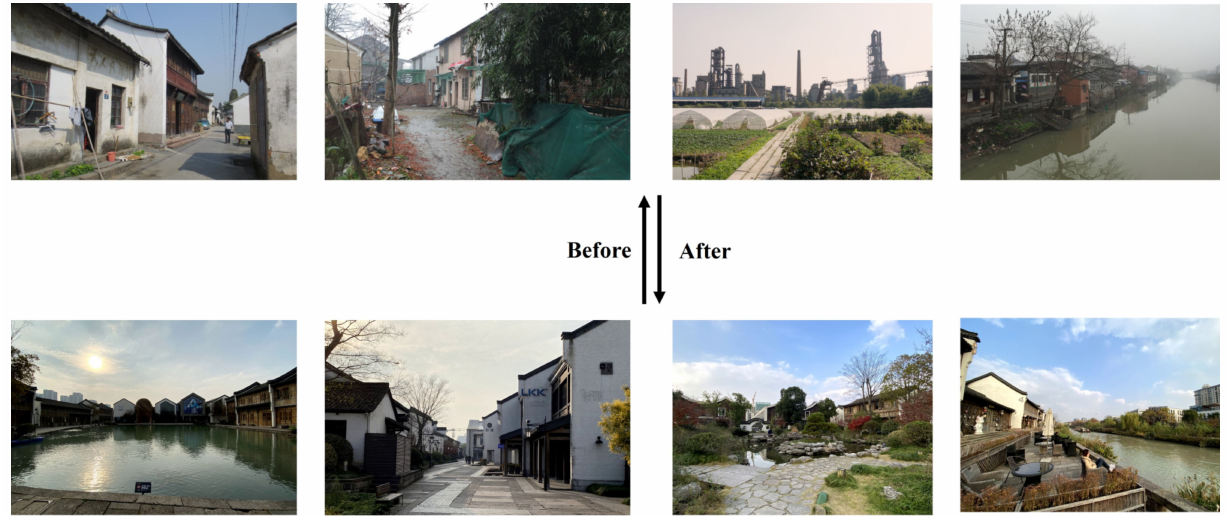
Figure 2. Scenes of the area where YDT is located before and after the Characteristic Town (CT) development (source: authors’ compilation).